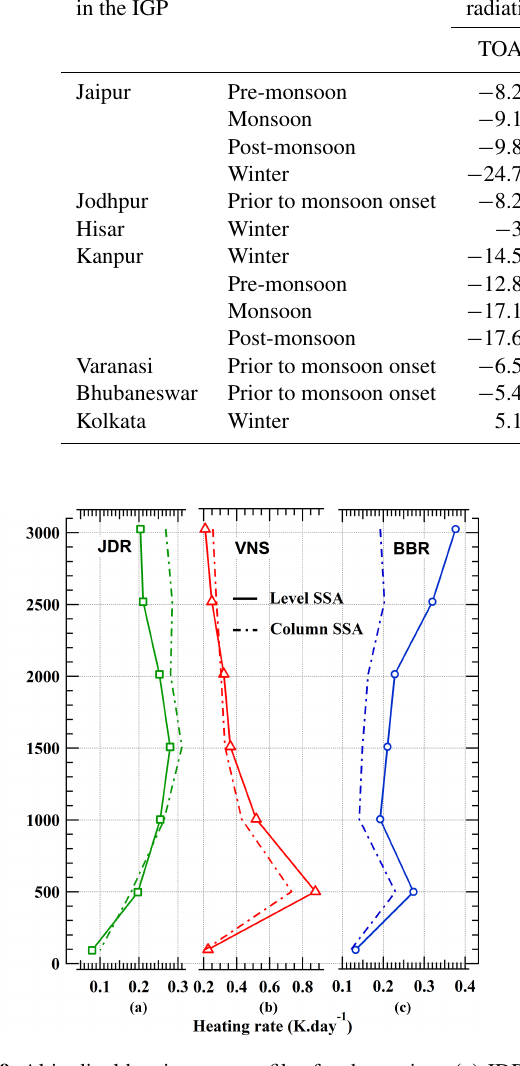
Table 4. Aerosol-induced short-wave radiative forcing at various locations in the IGP. Location